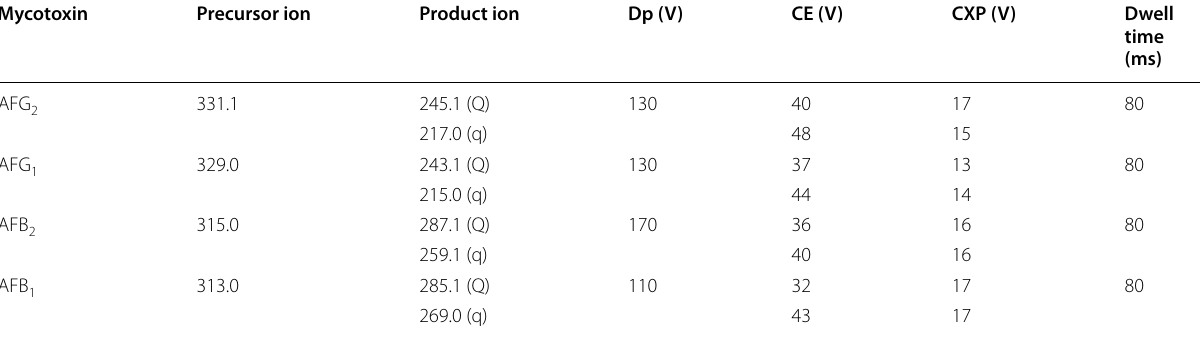
, AFG , AFB and AFB 2 1 2